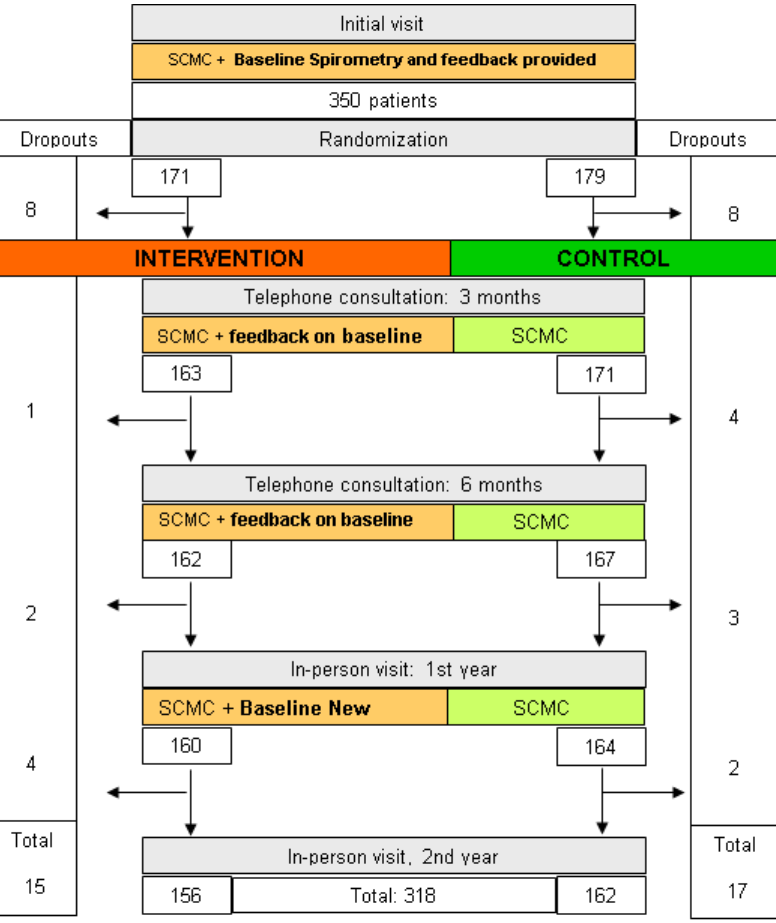
Figure 1. Patient flow and tests performed at the visits.